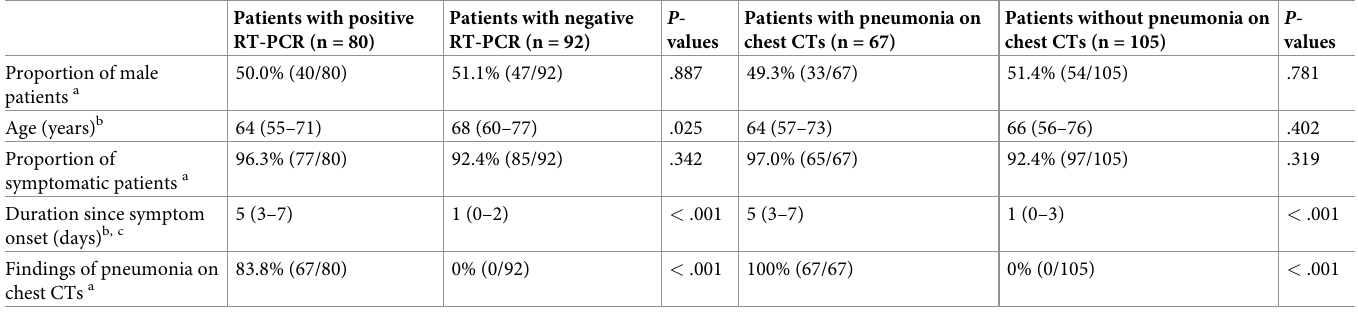
Patients with positive RT-PCR (n = 80)